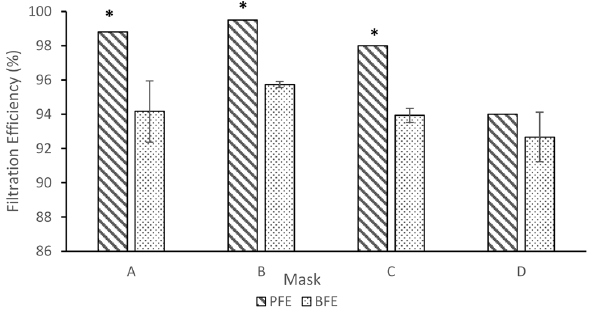
Figure 3. Comparison of filtration efficiencies between the PFE test protocol and BFE test protocol. *Significantly different from